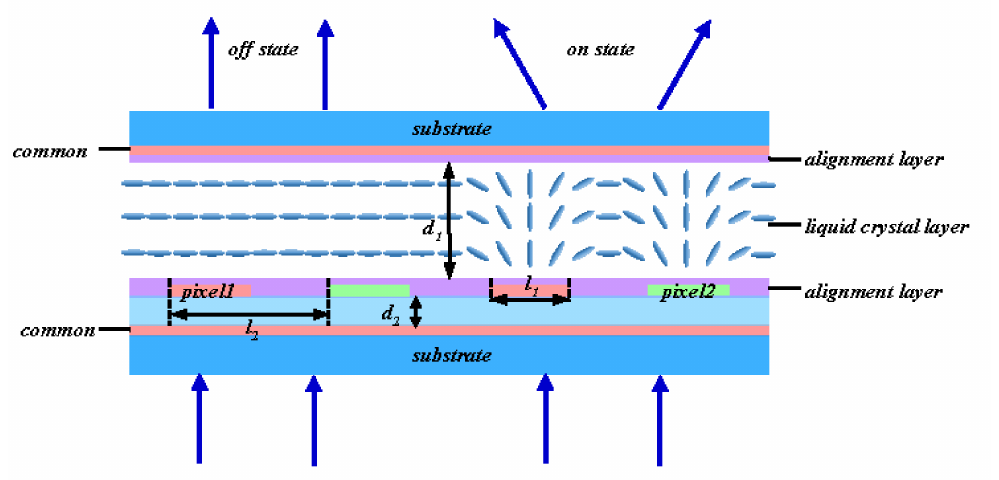
Figure 2. The cross section view of the liquid crystal lens-like